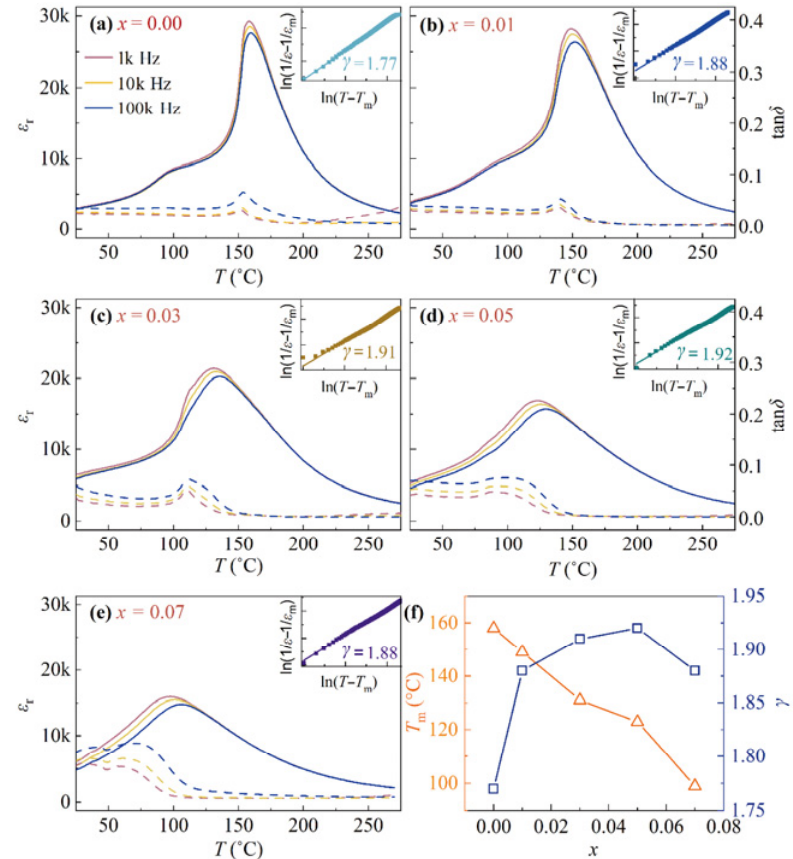
Fig. 3 (a–e) Temperature dependence of ε r and tan δ of PMN–PT– x BNZ ceramics; the insets are graphs of ln(1/ ε − 1/ ε m ) vs. ln( T − T m ) for ceramics at 1 kHz. (f) T m and γ of samples. All measured ceramics were